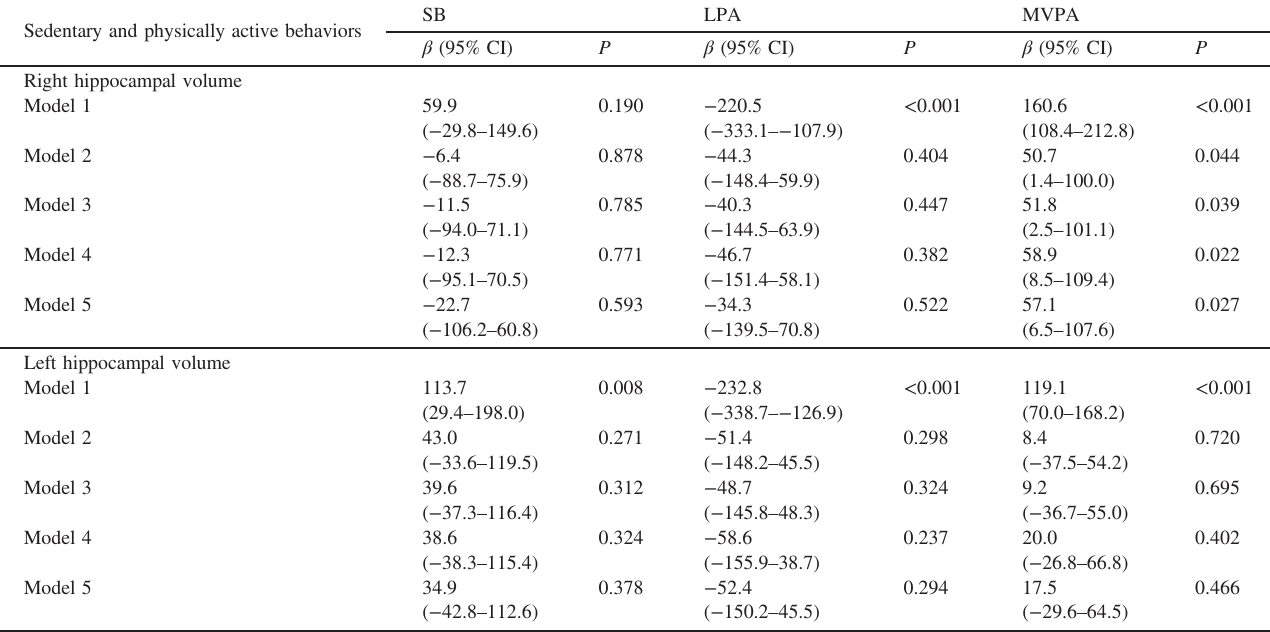
Table 3. Associations between sedentary and physically active behaviors and hippocampal volume in older